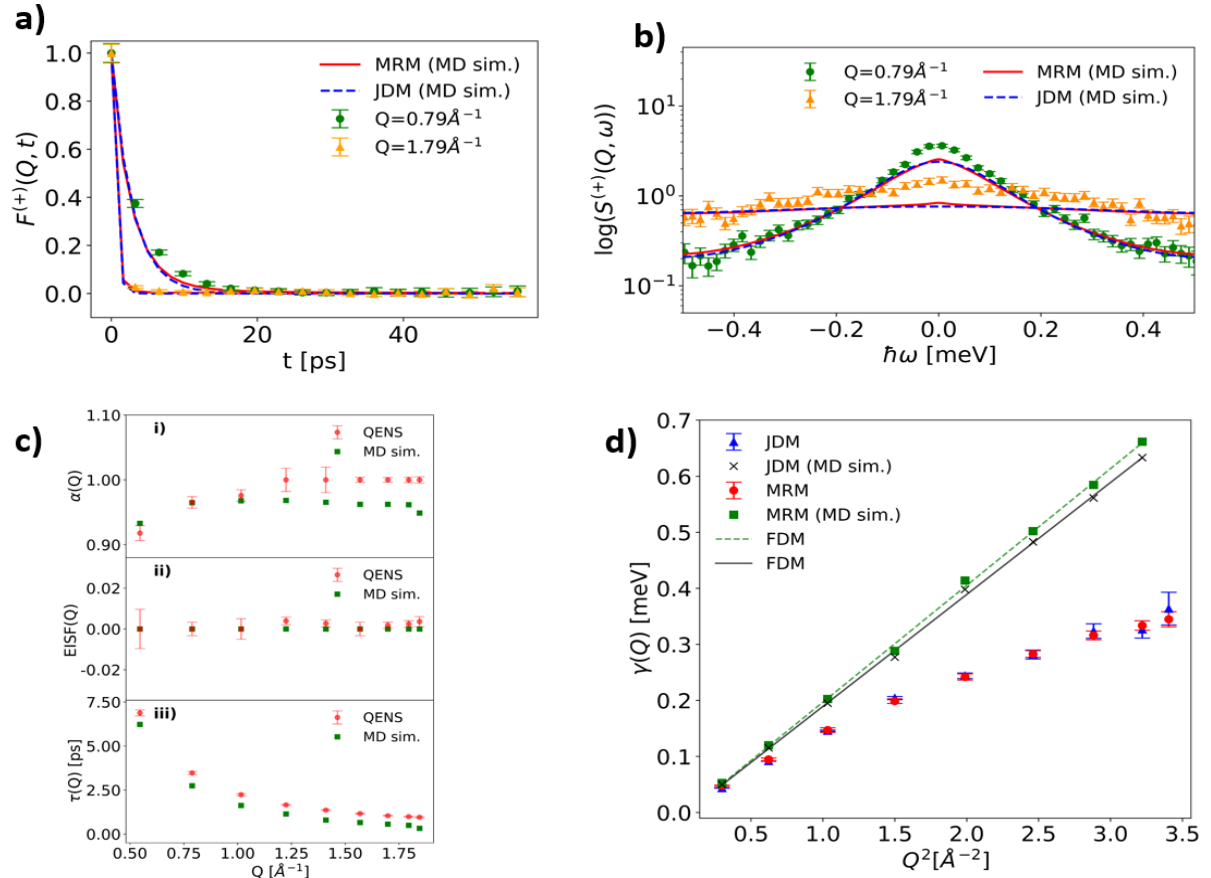
Figure 5. Overview of the data analysis performed on the MD simulation of bulk-water at 300 K . a) The symmetrized, normalized, and deconvolved intermediate scattering function, F ( + ) ( Q , t ), of the QENS data for bulk-water at 300 K plotted together with the jump di ff usion model (JDM) fit and multi-scale relaxation model (MRM) fit of the MD simulation, according to a single exponential function and Eq. 8. b) The fitted models transformed into the symmetrized, normalized and convolved dynamic structure factor, S ( + ) ( Q ,ω ), plotted alongside the QENS spectra of bulk-water at 300 K for comparison. c) Water dynamics parameters for the QENS data and MD simulation as a function of Q obtained from the multi-scale relaxation model fit of F ( + ) ( Q , t ): i) α ( Q ), ii) the EIS F ( Q ), and iii) τ ( Q ). The lack of Q-dependence and zero value for the EIS F ( Q ) reflects that, as expected, the water molecules are not spatially constrained. d) Extracted half width at half maximum (HWHM) γ ( Q ) JDM ( MD ) for each JDM fit of the QENS spectra and MD simulation as a function of Q 2 , compared to the HWHM γ ( Q ) MRM ( MD ) determined from the τ ( Q ) parameter of the MRM fit of the QENS spectra and MD simulation. Both HWHM for the MD simulation are fitted using the free di ff usion model (FDM), γ ( Q ) = D t Q 2 + const . resulting in D JDM ( MD )